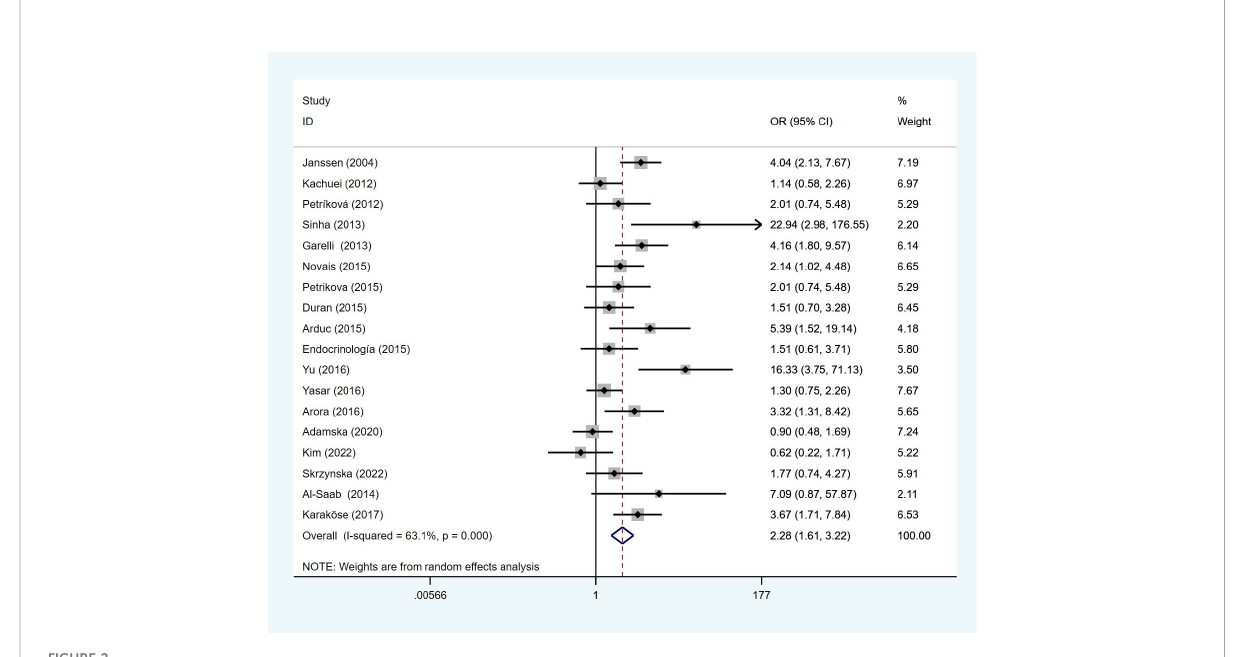
FIGURE 2 Forest plot of HT risk in PCOS patients and non-PCOS